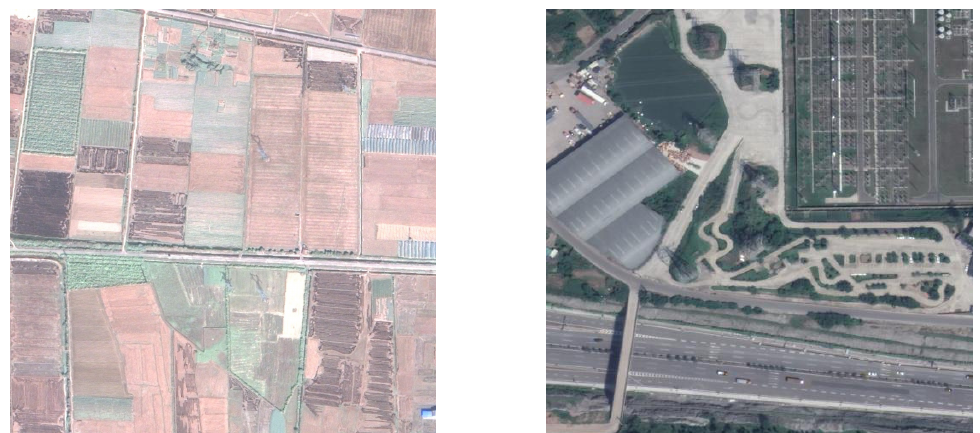
Figure 3. Image samples in the complex test subset EPD-C. The left one was captured by Pleiades satellite, where the detection difficulty mainly lies in the similarity of color characteristics between the background and electric pylon targets. The right one was collected from Google Earth, where the detection difficulty mainly reflects on interference from frame structure buildings.